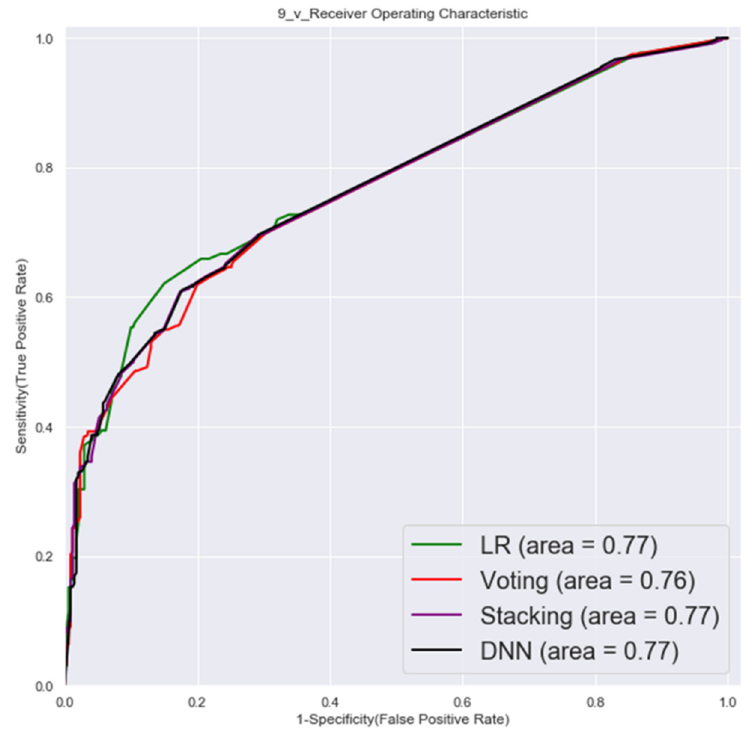
Figure 6. Testing set ROC (second factor combinations).